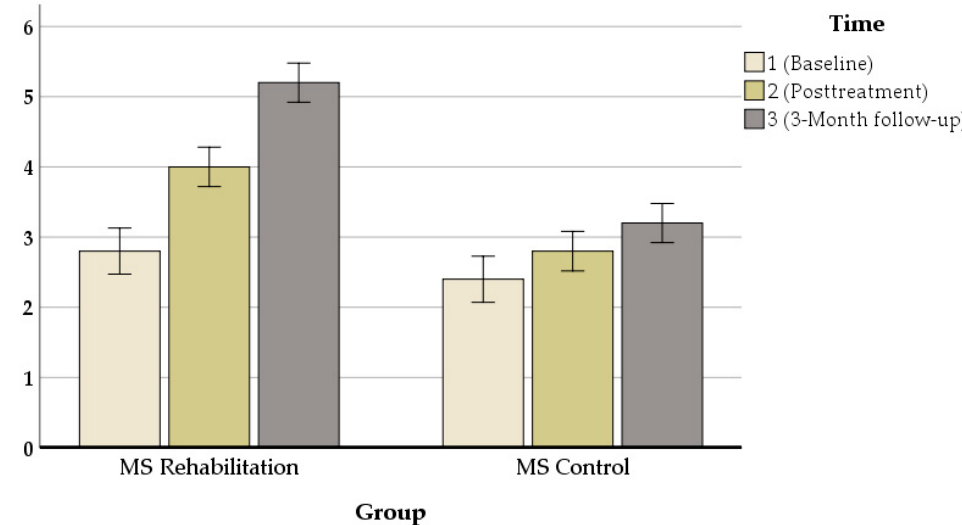
Figure 4. Composite visual/spatial memory (BVMTR) performance (z-scores) in the ICRP interven- tion group and control group at baseline and posttreatment.